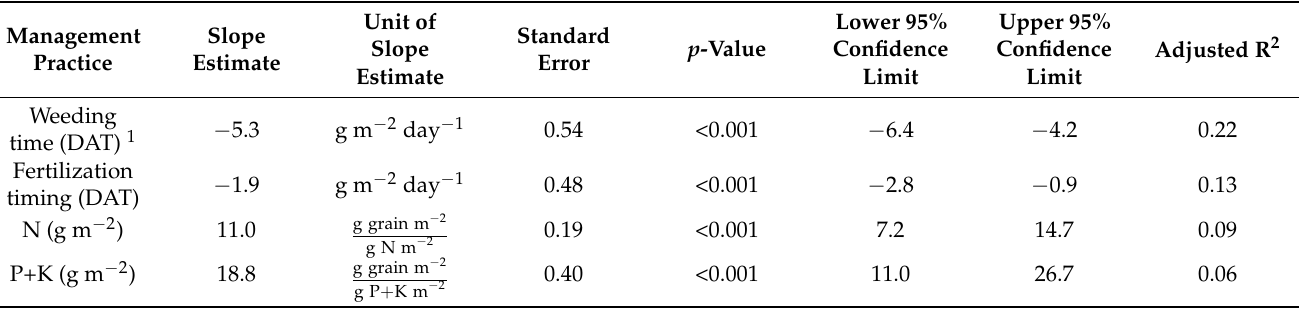
Table 4. Effect of management practices on yield variation among treatment plots on farmers’ fields, Doho 2019.